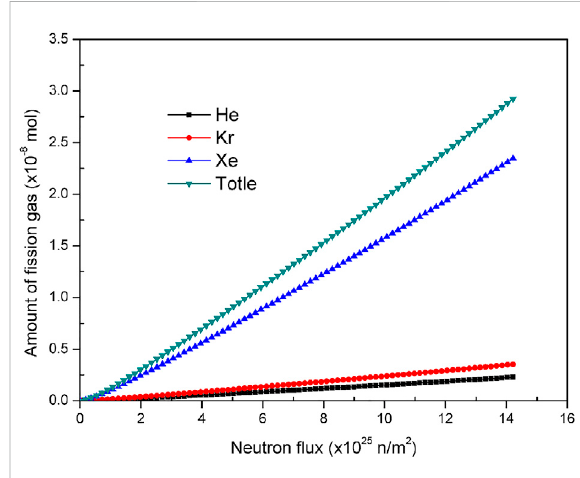
Variation of theamount of gas released from aTRISO particle with neutron fl